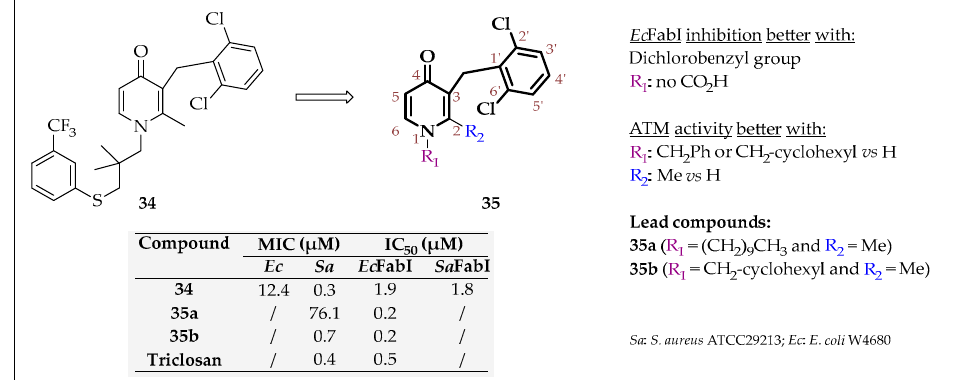
Figure 32. Structure and SAR of 4-pyridone derivatives 34 and 35 and in vitro activities